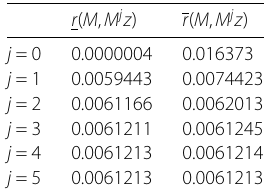
Table 2 Collatz–Wielandt numbers for M j z in the example